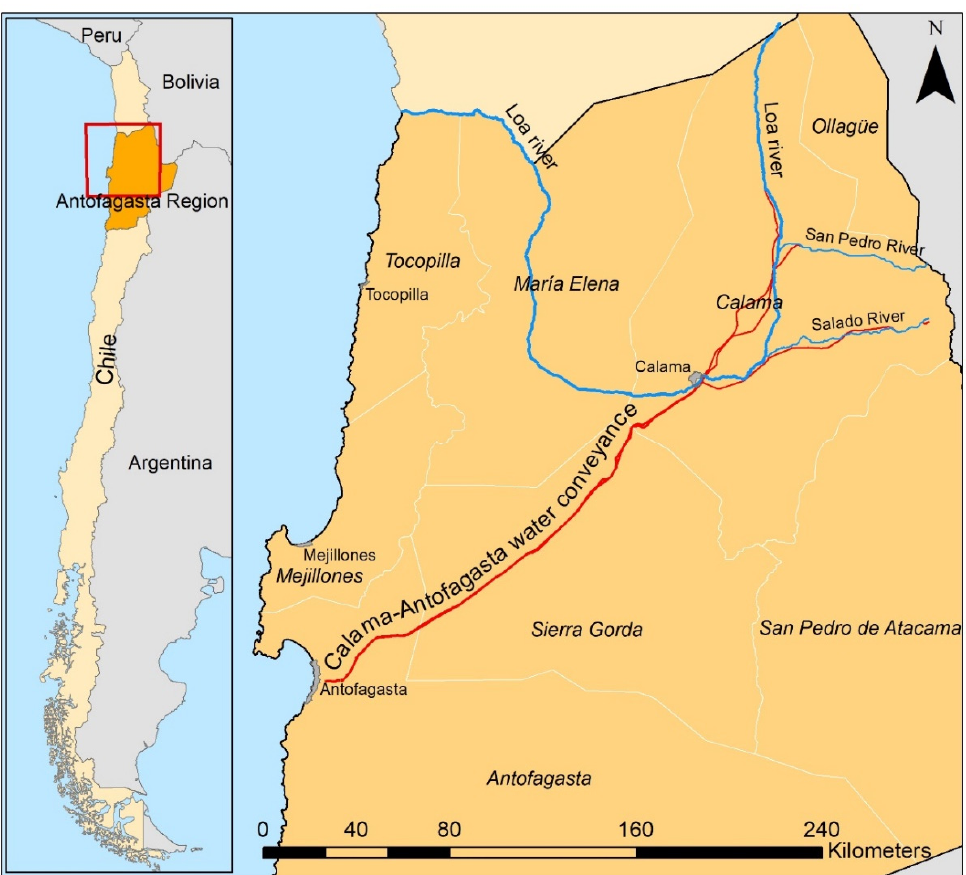
Figure 1. Antofagasta’s location and regional water conveyance system .